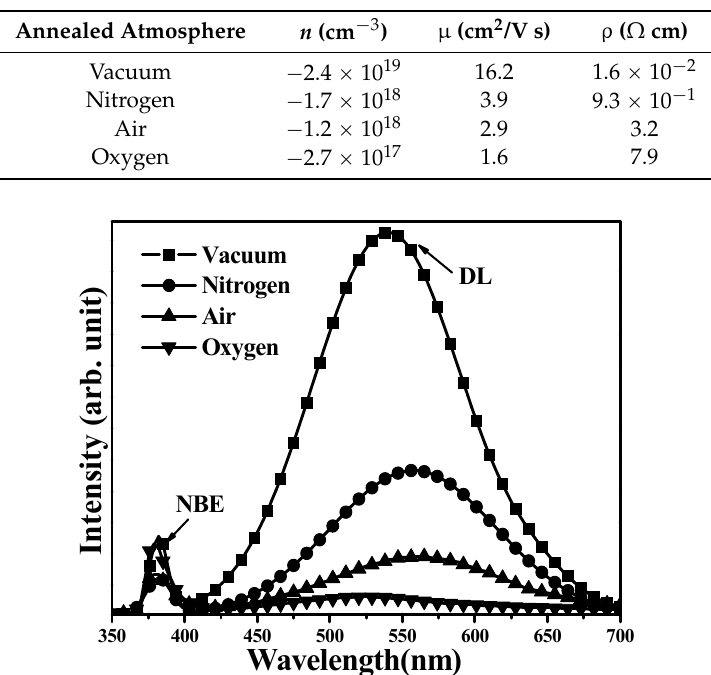
Figure 5. Room temperature PL spectra of n ‐ ZnO films annealed at 700 °C under vacuum, nitrogen, air, and oxygen atmospheres, respectively, for 30 min.